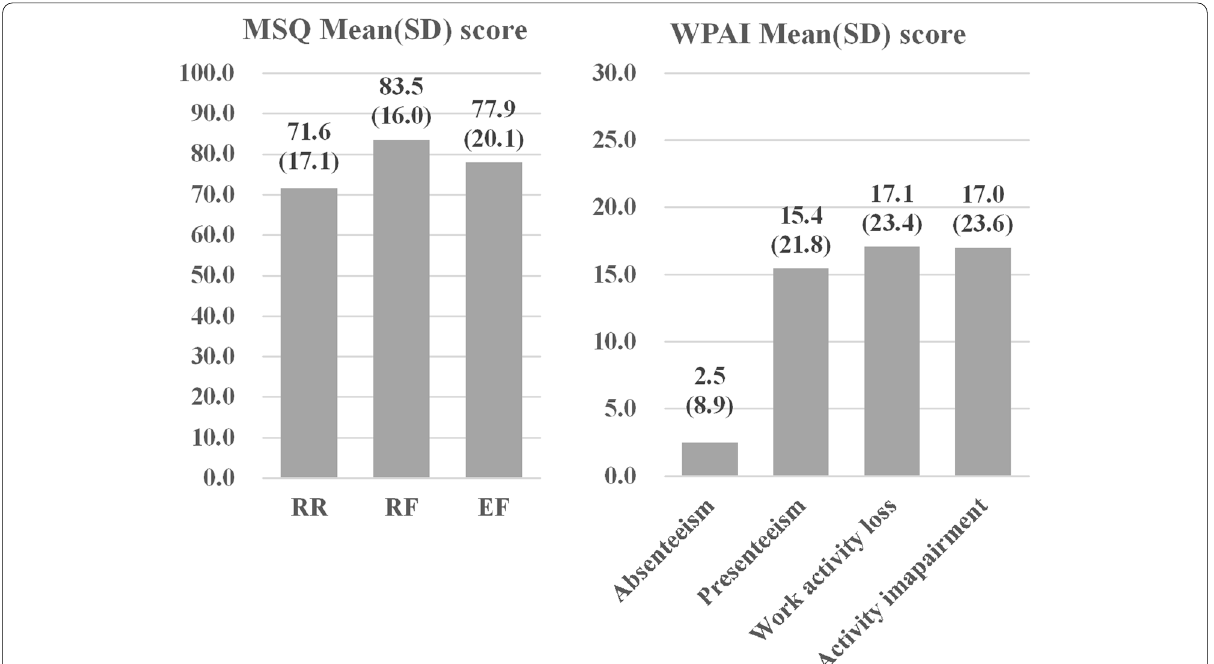
Fig. 5 Domain scores of MSQv2.1 and WPAI in people with migraine ( n 691). Abbreviations: MSQ, Migraine-Specific Quality of Life Questionnaire; = WPAI, Work Productivity and Activity Impairment Questionnaire; RR, role function—restrictive; RF, role function—preventive; EF, emotional